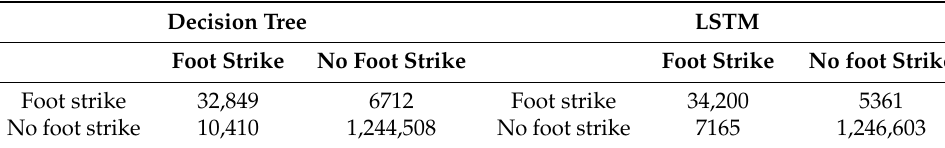
Table 1. Confusion